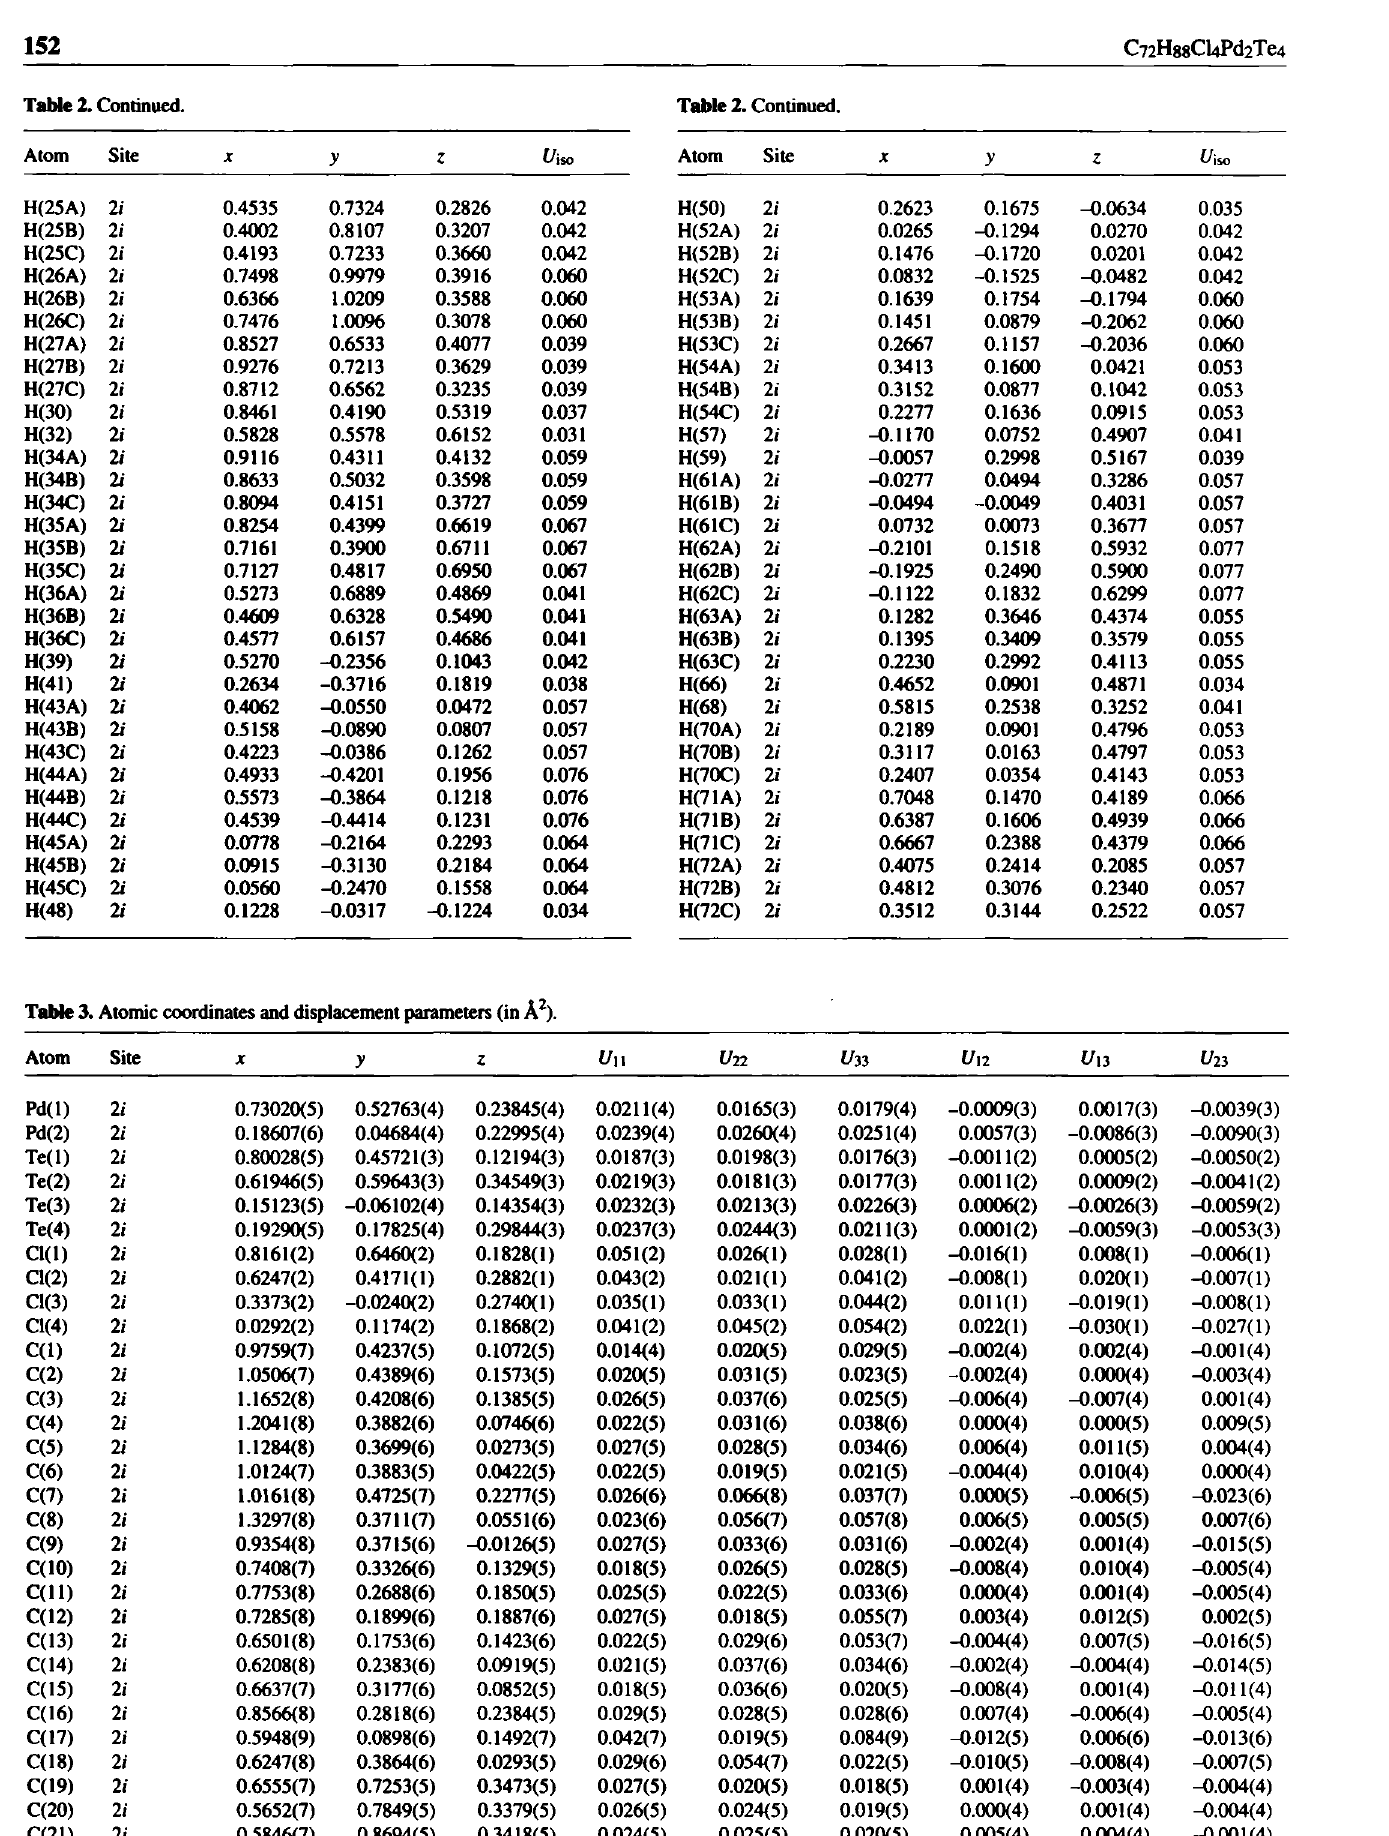
Table 3. Atomic coordinates and displacement parameters (in À 2